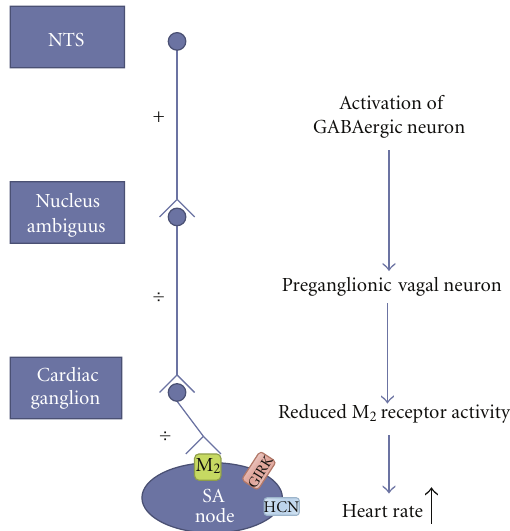
Figure 1: Model of how activation of GABAergic input to the cardiac vagal neurons increases heart rate. GABAergic neurons from the nucleus tractus solitarius inhibits the preganglionic cardiac vagal neurons, which leads to reduced postganglionic vagal input to the heart. Consequently, the muscarinic acetylcholine receptor (M 2 ) activity is reduced. Because the G i protein no longer inhibits the production of cAMP by the adenylyl cyclase, HCN channel activity is increased. In addition the G protein-coupled inwardly rectifying potassium channel (GIRK) is no longer activated. Together this will cause the heart rate to